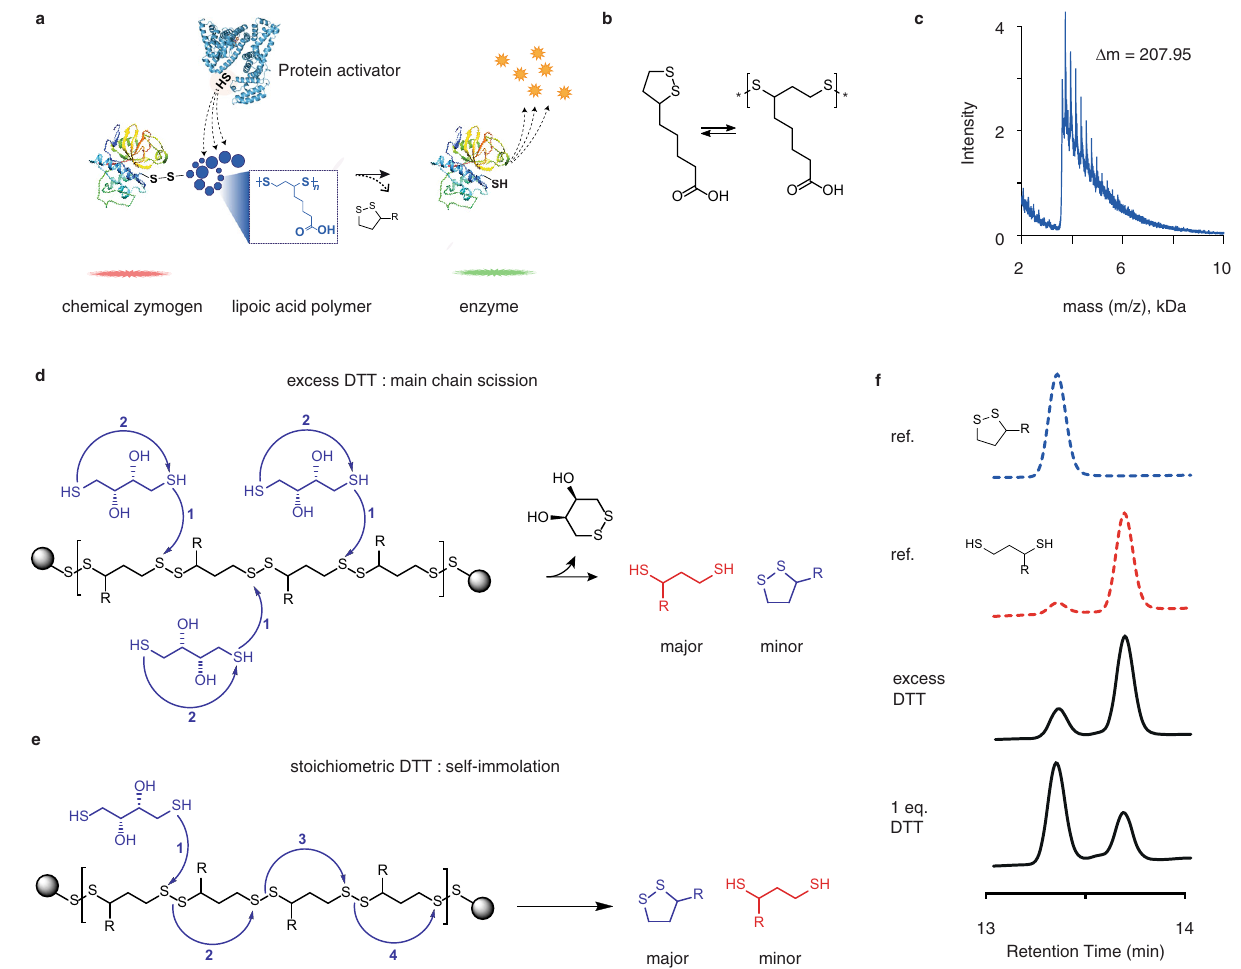
Fig.1|Polydisul fi depolymerbasedonlipoicacid.a Schematicillustrationofthe proposed self-immolative polydisul fi de as a tool to collect activating chemical signal in solution and propagate it to the sterically hindered active site of an enzyme; b Chemical formula of lipoic acid and schematic illustration of its rever- sible polymerization into a linear disul fi de; c MALDI spectrum of the lipoic acid polymer that shows inter-peak spacing of 207.95Da, in agreement with the struc- ture of lipoic acid as the monomer unit; d , e schematic illustration of mechanisms